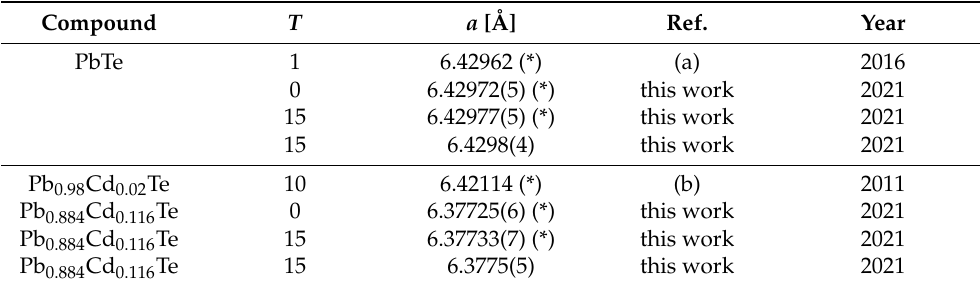
Table 6. Present and recently reported values of experimental lattice parameter, a , near 0 K for PbTe and Pb 1 − x Cd x Te ( x = 0.013, 0.056, 0.116). For complete numerical data of a ( T ) of this work, see Tables A1 and A2 (Appendix B).